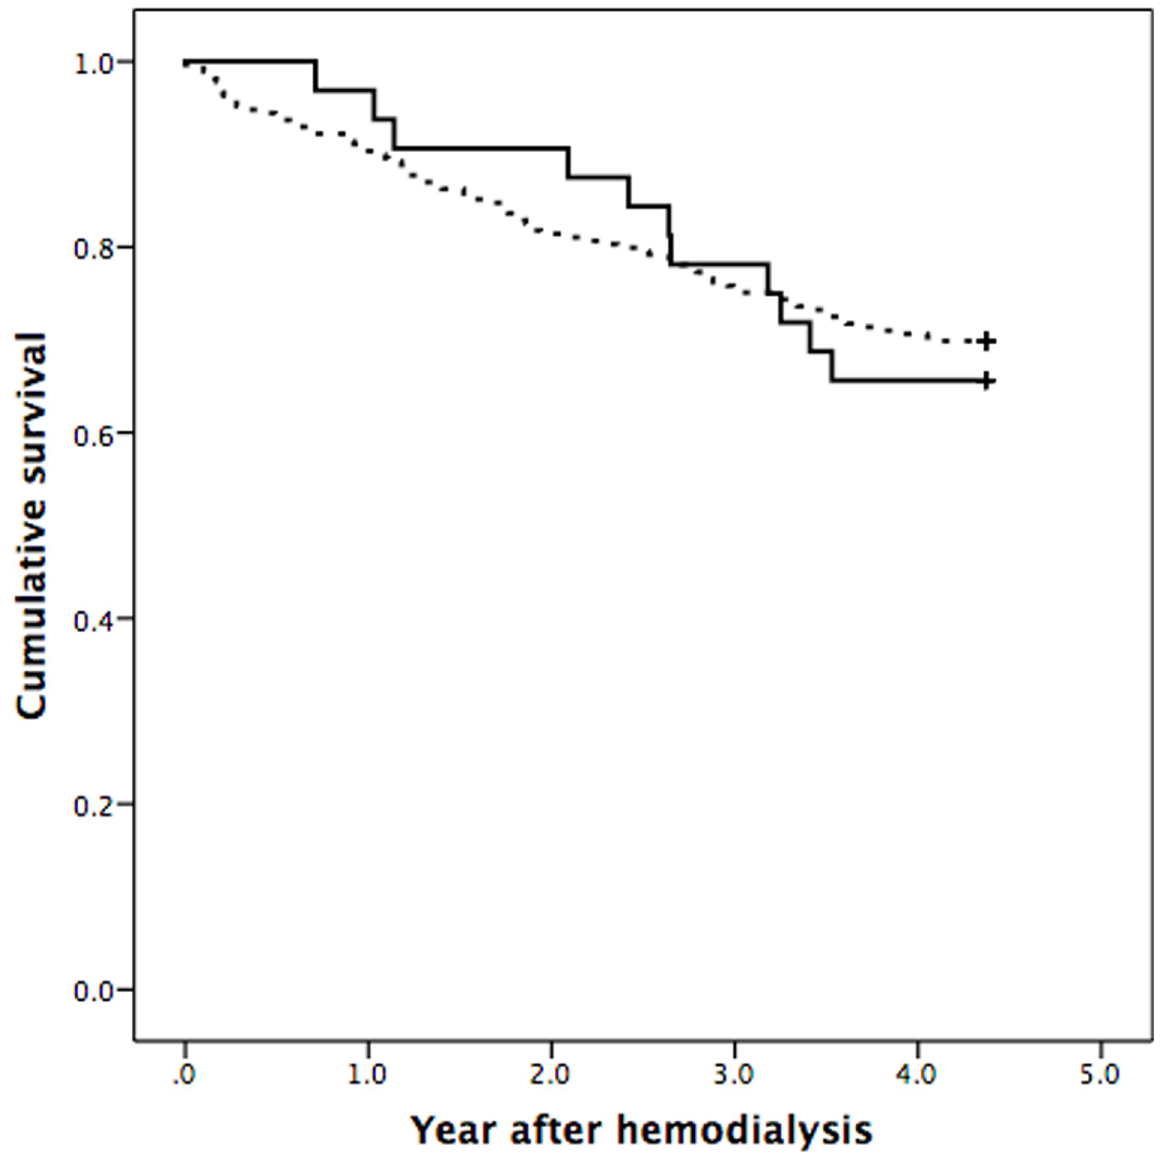
Fig 1. Kaplan-Meier analysis. There was no significant difference in cumulative survival between patients with small kidney size (solid line) and enlarged or normal kidney size (dashed line) (Log-rank test, Chi-Square 0.099, P =